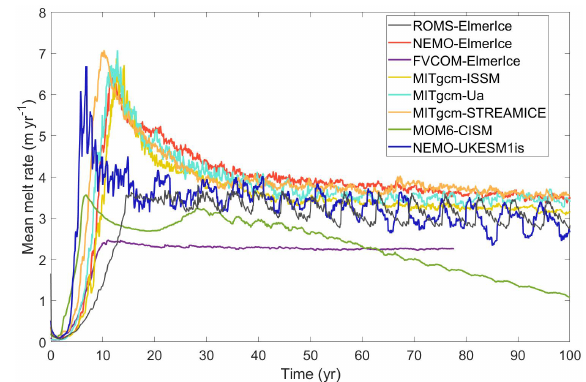
Figure 1. Simulated mean melt rates from different coupled models in the MISOMIP1 project (Xylar Asay-Davis, personal communi- cation,